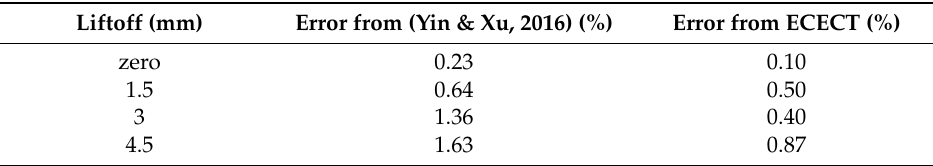
Table 4. Comparison of liftoff with different coating thickness.